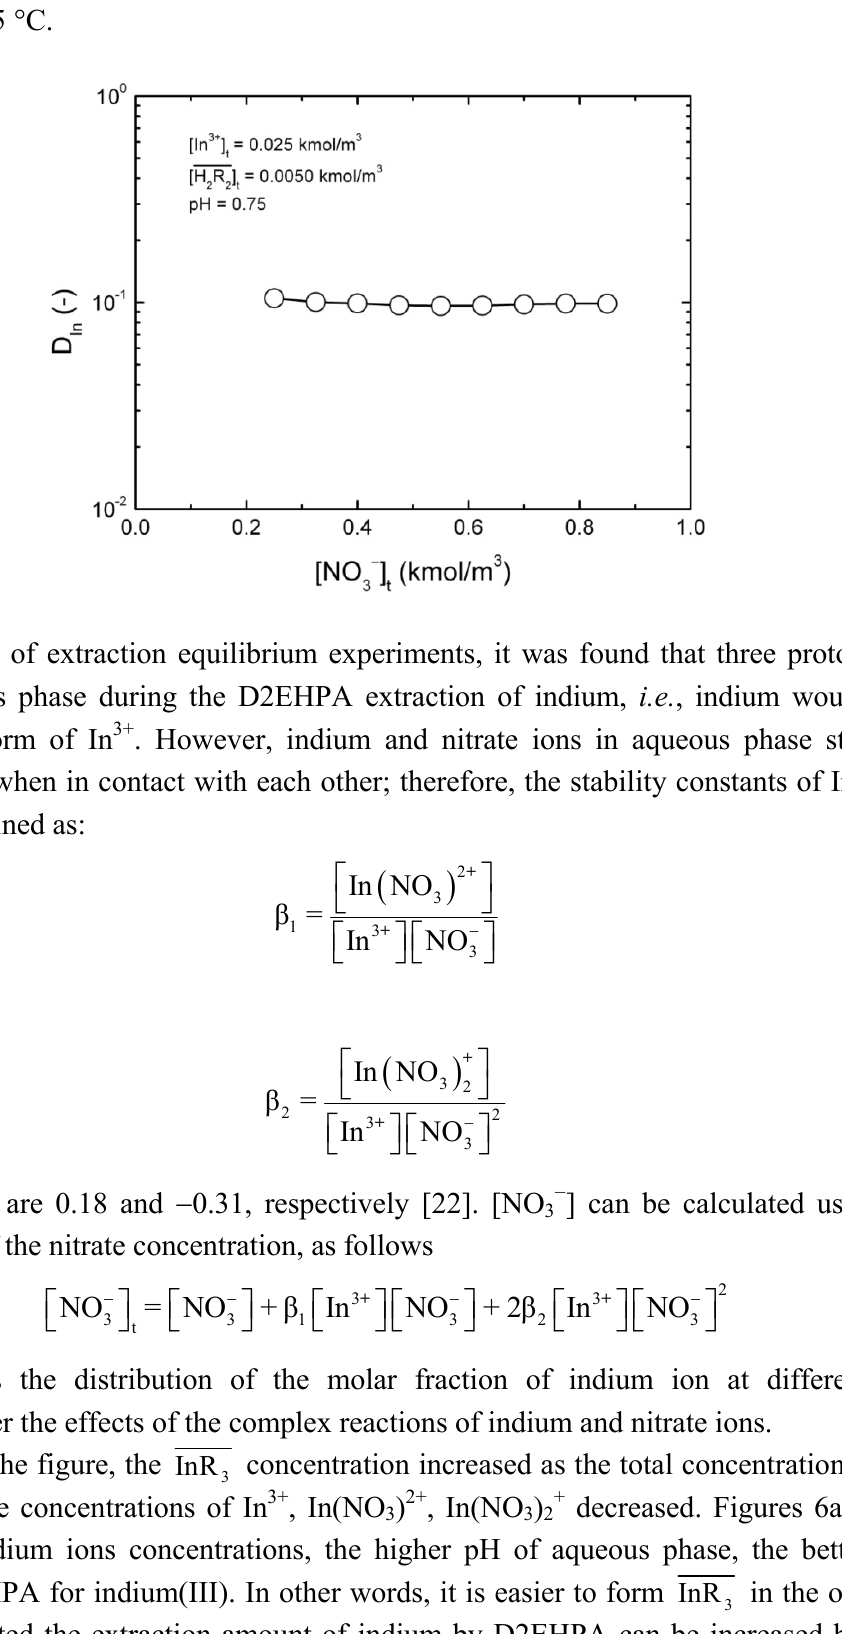
Figure 5. Effect of concentration of nitrate on the extraction of indium with D2EHPA in kerosene at 25 